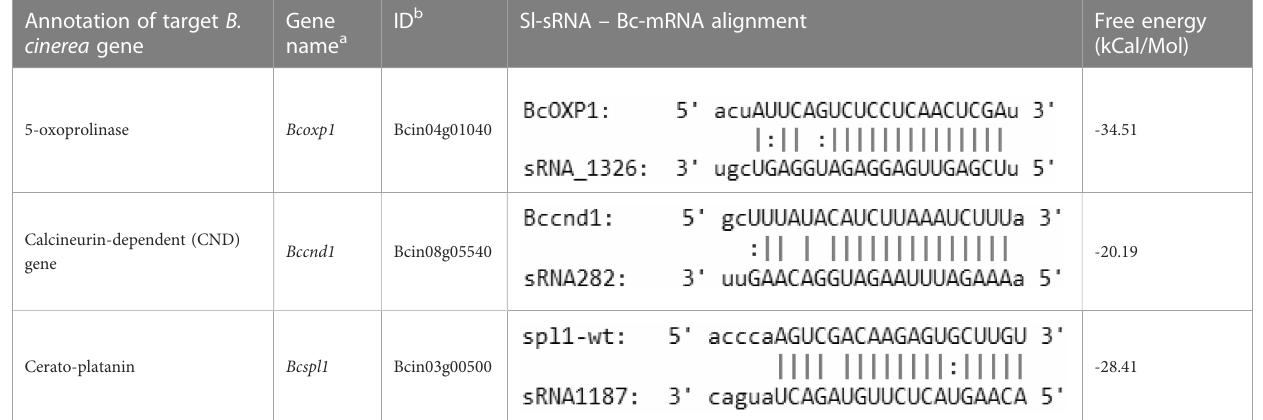
TABLE 2 Selected predicted B. cinerea target genes and their corresponding Sl-sRNA sequences.